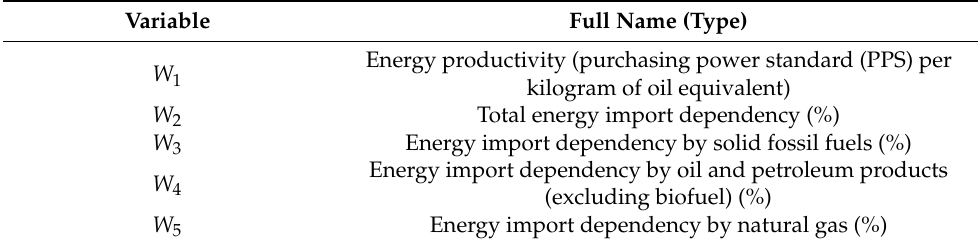
Table 2. Indicators for assessing energy